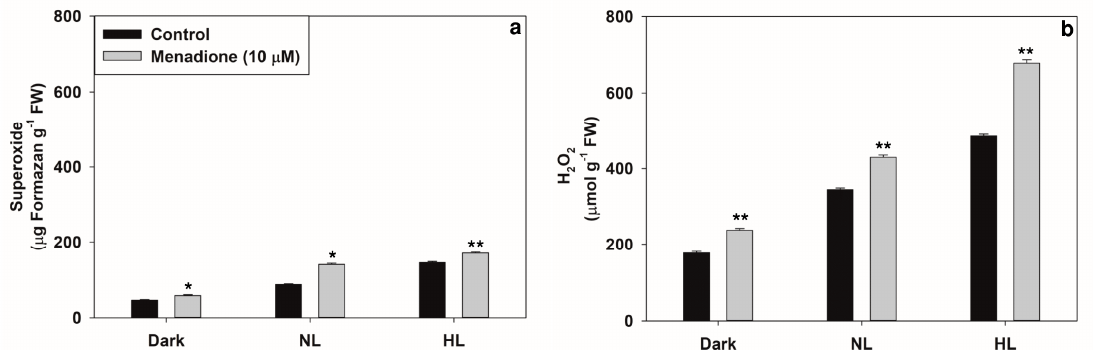
Figure 1. Leaf discs were treated with menadione (MD 10 µ M) and incubated under dark, normal (NL, 300 µ mol m − 2 s − 1 ) or high light (HL, 1200 µ mol m − 2 s − 1 ) light for 3 h and quantification of generated superoxide and H 2 O 2 . Another set had no MD, but were kept in dark, NL or HL. ( a ) Formazan, precipitate formed from the reduction of NBT by superoxide. ( b ) Levels of H 2 O 2 detected by DAB-staining. Each data point is the average of three replicates and error bars represent ± SE. Asterisks indicate the significance of MD effect compared to the respective control. * p < 0.05; ** p < 0.001.